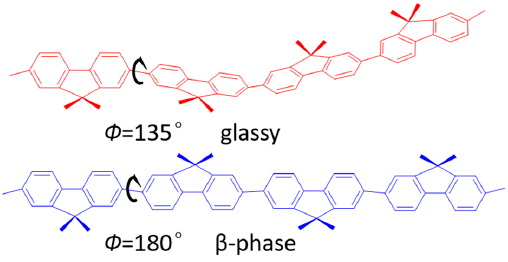
Figure 1. The differences inter-monomer torsion angle Φ between the glassy and β -phase PFO chain conformations. The n-octyl side-chains of PFO (C 8 H 17 ) are omitted for clarity.